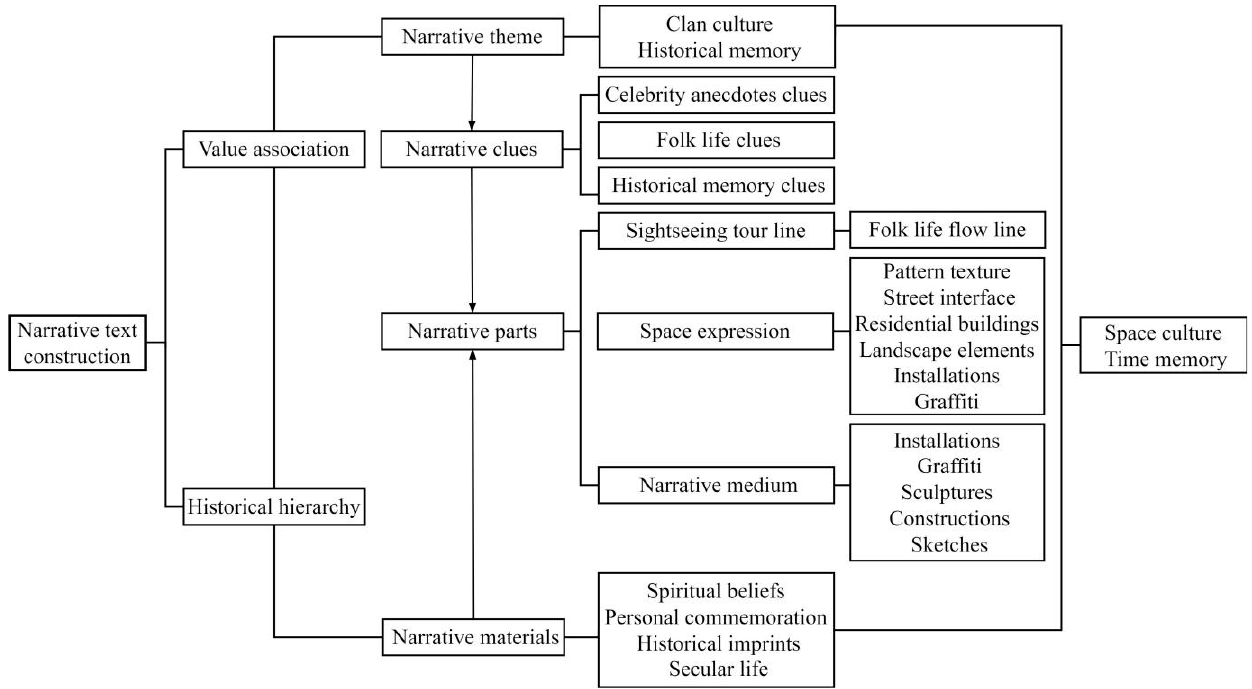
Figure 5. Construction of narrative text. (Source: the authors).